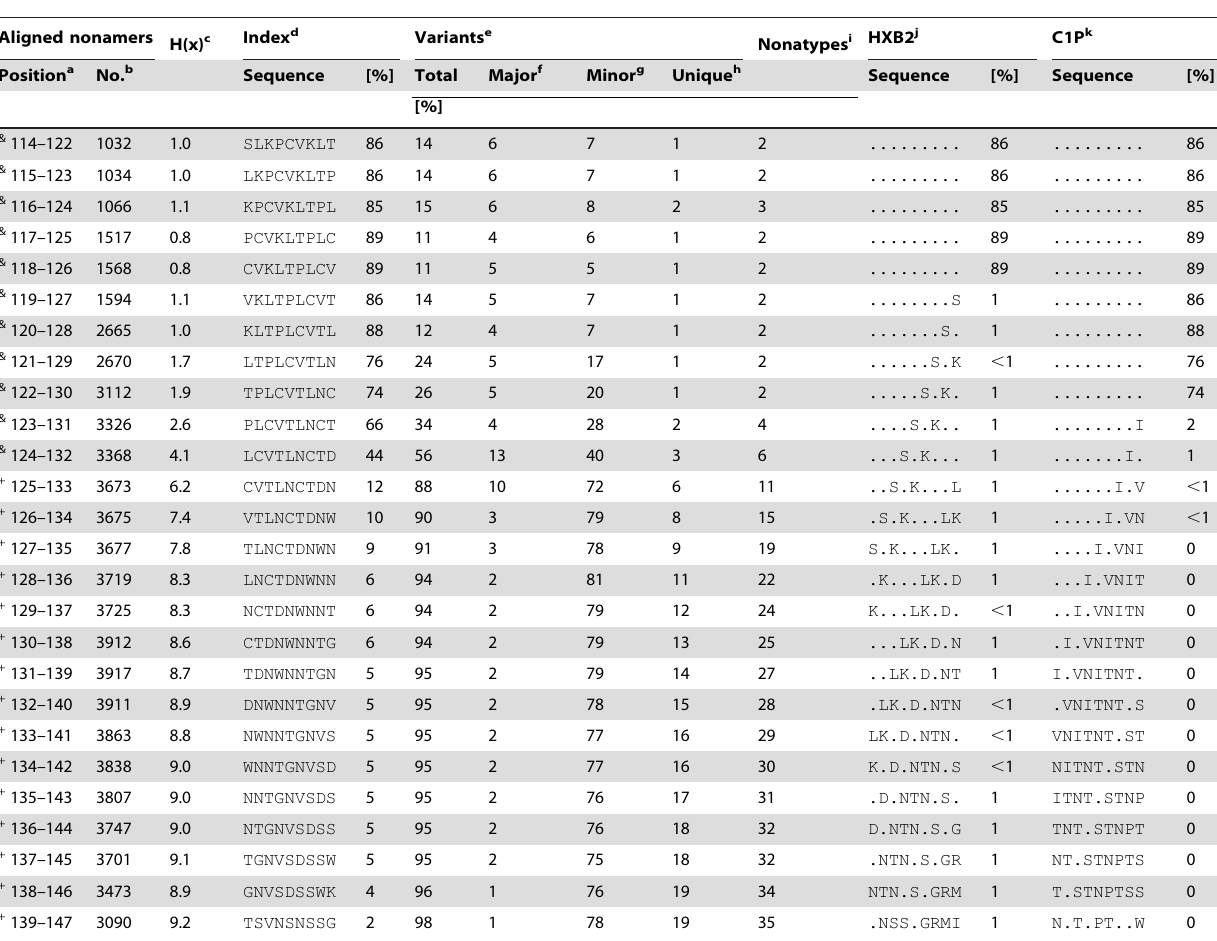
Table 1. A sample of the quantitative analysis of HIV-1 clade B Env protein diversity ‘ .